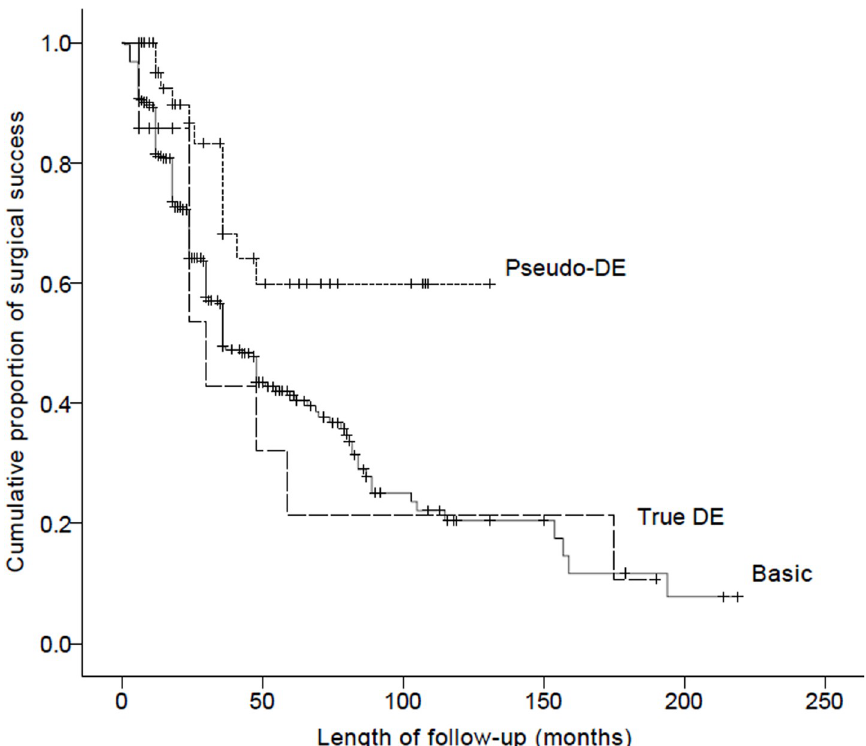
Fig 1. Survival curves for recurrence in basic, pseudo-DE, and true DE types of intermittent exotropia. Pseudo-DE showed significantly lower recurrence compared with basic and true DE (P < 0.003, 0.02, log rank test).